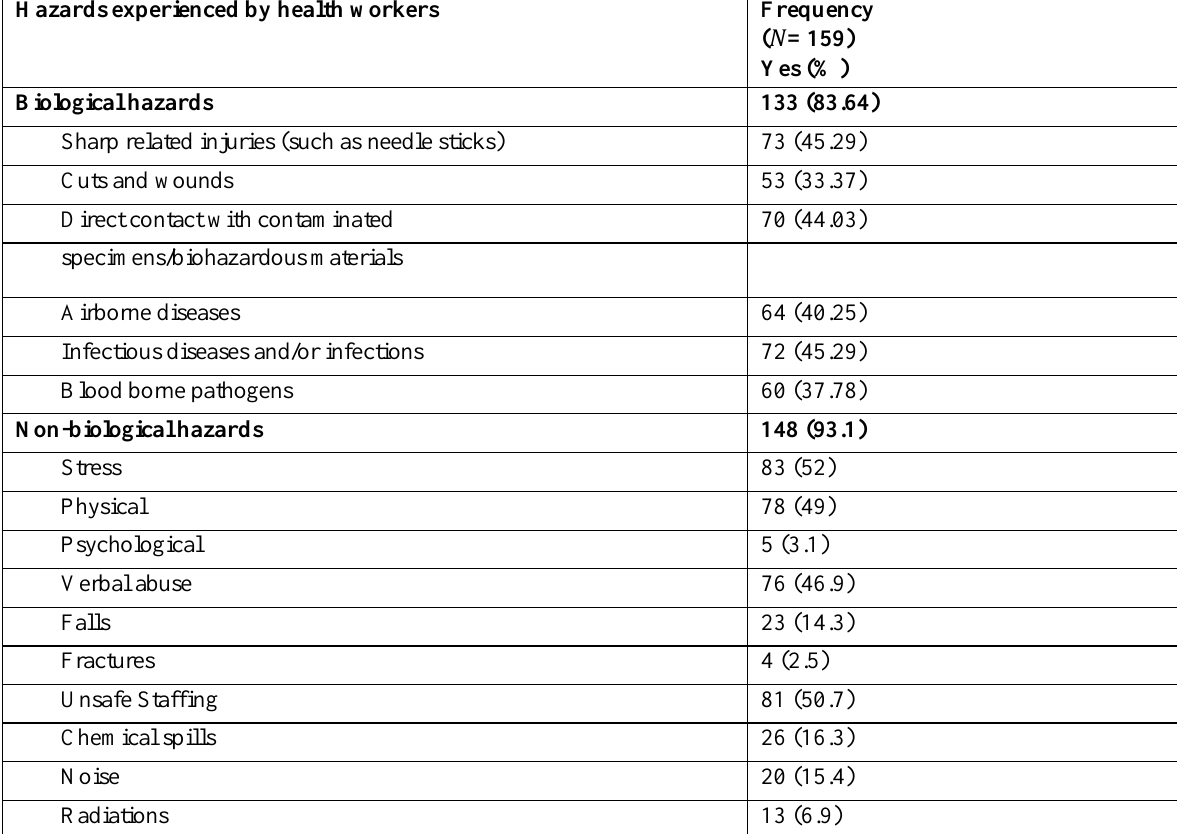
Table 7. Summary of Biological/Non-Biological Hazards within the study Sample Hazards experienced by health